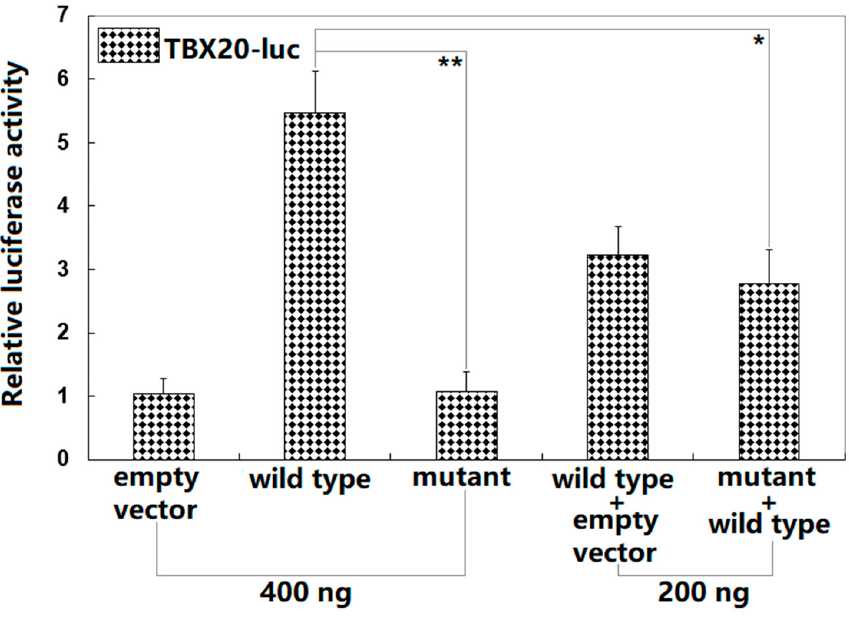
Figure 5. Functional loss of BMP10 resulted from the Gln56* variation. The reporter assay of the transcriptional activation of the TBX20 promoter-driven luciferase expression in cultivated HeLa cells by wild-type BMP10 or Gln56*-mutant BMP10 (Gln56*), alone or together, unveiled that the Gln56* variant had no transcriptional activity. For each expression plasmid utilized, three independent transfection experiments in vitro were conducted in triplicate. The student’s unpaired t -test was applied to make the comparison between the two groups. Herein * and ** indicate p < 0.001 and p < 0.01, respectively, in comparison with wild-type BMP10 (400